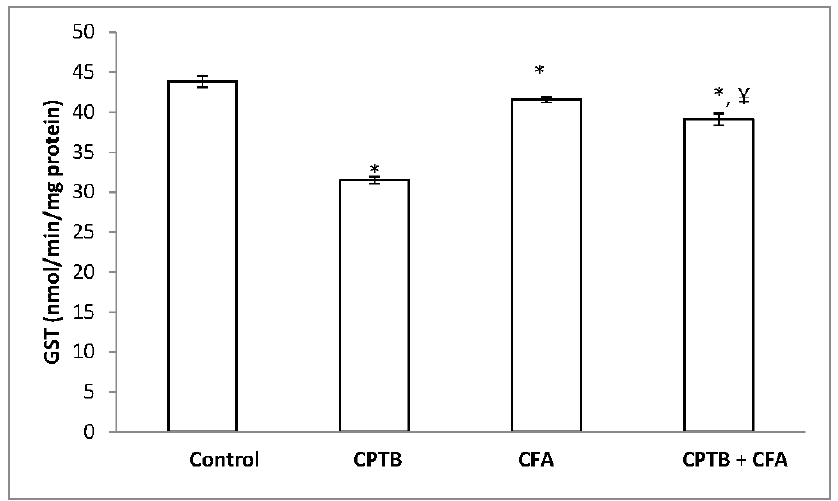
Figure 3. Influence of caffeic acid on capecitabine-induced changes in hepatic GST activity in rats. Data are expressed as means ± SD for six rats in each group; * significantly different from the control ( p < 0.05); ¥ significantly different from the capecitabine group ( p < 0.05).